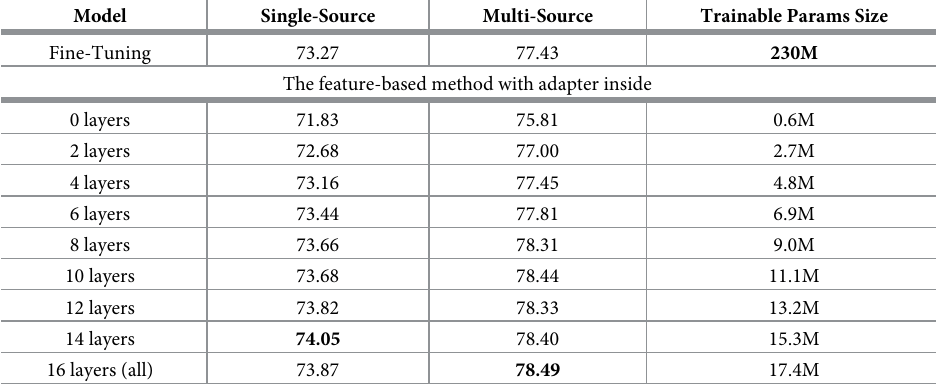
Table 5. The comparisons between the fine-tuning and feature-based adapter exploration methods, where XLM is used as the input language